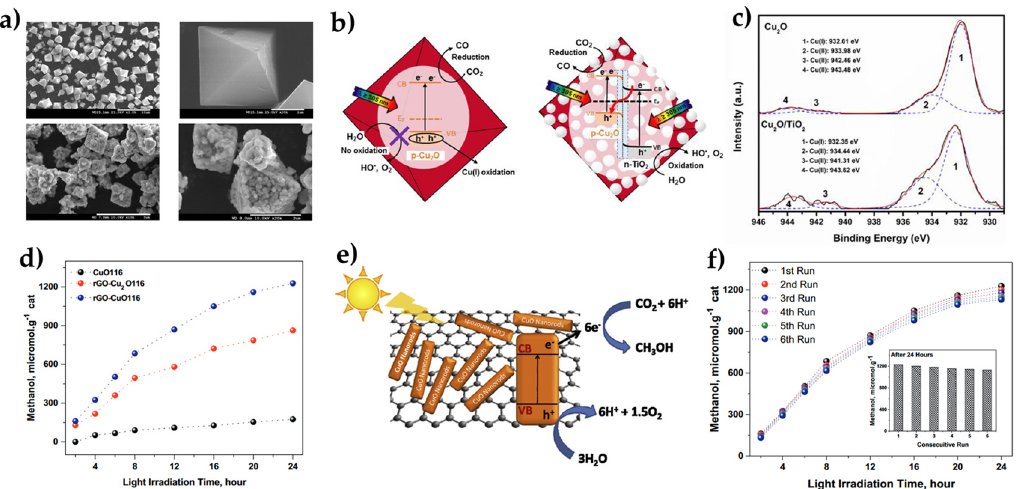
Figure 12. ( a ) SEM images of Cu 2 O (top) and Cu 2 O/TiO 2 composite (bottom) where the surface of Cu 2 O octahedral particles is covered with TiO 2 NPs; ( b ) Schematic presentation of the proposed CO 2 reduction mechanism induced by λ ≥ 305 nm; ( c ) XPS spectra for Cu 2p 3/2 for pristine Cu 2 O (top) and Cu 2 O/TiO 2 (bottom). Reprinted from [67], with permission from Elsevier; ( d ) CH 3 OH yields of CuO, rGO − CuO and rGO − Cu 2 O composites; ( e ) Schematic representation of the CO 2 conversion mechanism to CH 3 OH using the rGO − CuO116 composite under visible light irradia- tion; ( f ) Stability/recycling experiments of rGO − CuO116. Inset figure shows CH 3 OH yields after 6 consecutive catalytic runs. Reprinted from [100] with permission from Elsevier.